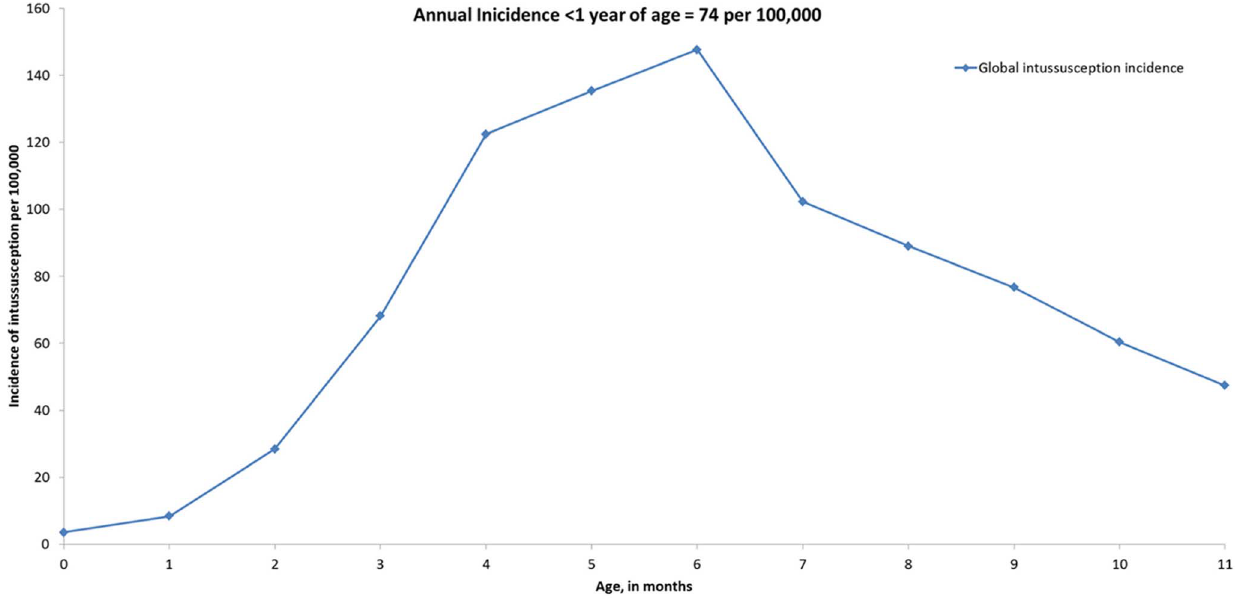
Figure 3. Incidence of intussusception by month of life during first year of life. Intussusception incidence or number of cases by month of life from 22 studies extrapolated to remaining 13 studies that only presented data on rates for infants , 1 year (as displayed in Table 2).